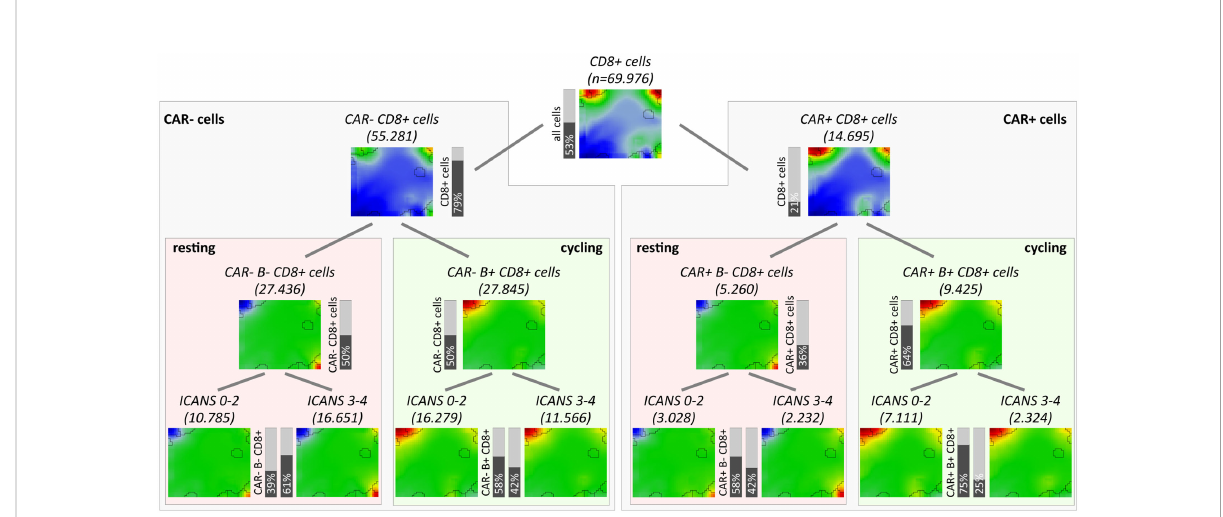
FIGURE 6 Overview of subpopulation expression portraits and relative abundances. CD8+ T cells were hierarchically strati fi ed by CAR-status, by cell cycle activity as seen by module B expression, and by ICANS group (from top to bottom). Pairwise comparison of the ICANS portraits in the four main branches reveals virtually identical expression patterns between the low and high ICANS groups in each of the branches. Contrarily, the relative amounts of cells in the low and high ICANS groups show marked differences especially in cycling CAR-positive cells (right main branch) meaning that high ICANS associates with a roughly three times reduced fraction cycling CAR+ cells. This difference is reduced in non-cycling CAR+ and cycling CAR- cells and reverses in non-cycling CAR-